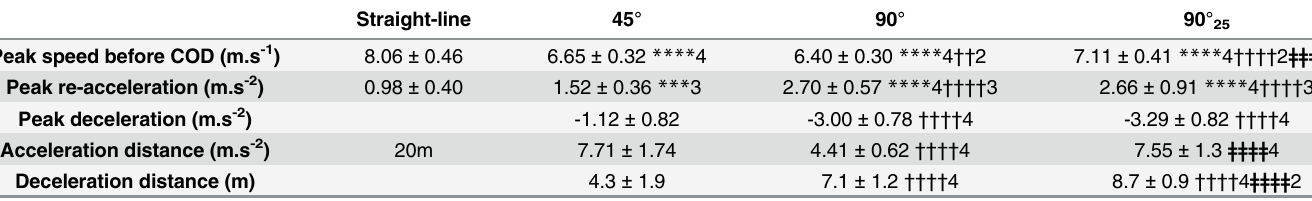
Table 3. Running variables during sprints with and without changes of direction.